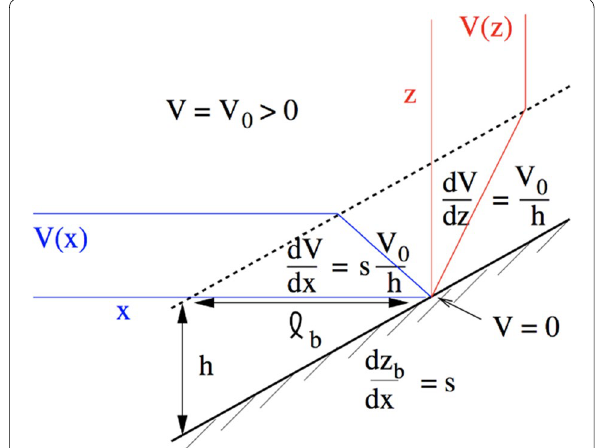
Fig. 13 Drag-induced vorticity generation on a slope. Sketch of vorticity generation in an along-slope current V ( x , z ) for a uniform interior flow V 0 and a turbulent bottom boundary layer over a slope with s = dz b / dx . The turbulent drag causes the bottom velocity to go to zero, leading to the local vertical profile V ( z ) (red) with a boundary-layer depth h and horizontal profile V ( x ) (blue) with vertical vorticity ζ = dV / dx due to the velocity shear on the horizontal scale ℓ b = h / s (Molemaker et al.